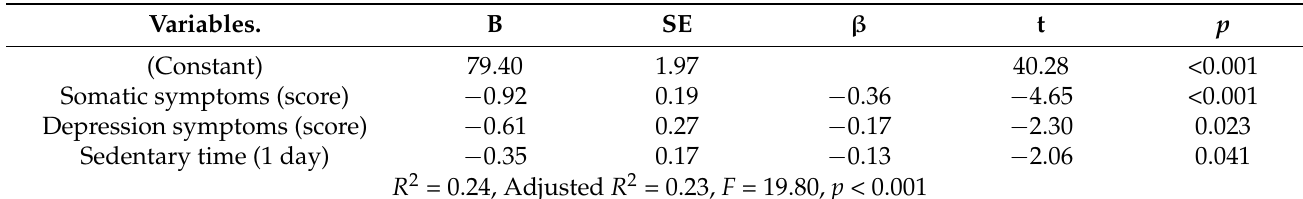
Table 4. Predictors of sleep quality in middle-aged women with CVD risk factors ( N = 204).